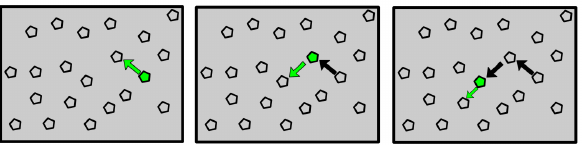
Figure 2. Neighbor search using the uniformity criterion. Source: Elaborated by authors.